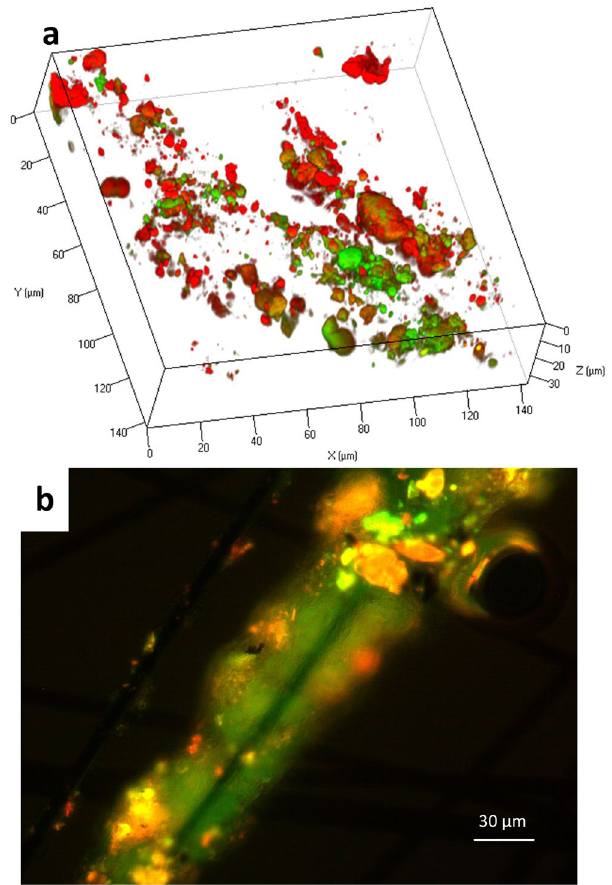
Figure 5. Fluorescence in situ hybridization (FISH) images of intact biofilms on carbon fibers from the microbial electrochemical cell anaerobic chamber (MxC AC ) anode. ( a ) shows the 3D structure of the colonies formed by Methanobacteriaceae family (green) and Geobacter genus (red) on the surfaces of a single carbon fiber; yellow indicates the overlap of green and red colors. ( b ) shows biofilm structure in 2D. Image a is obtained from a confocal microscope, and image b is from an epifluorescence